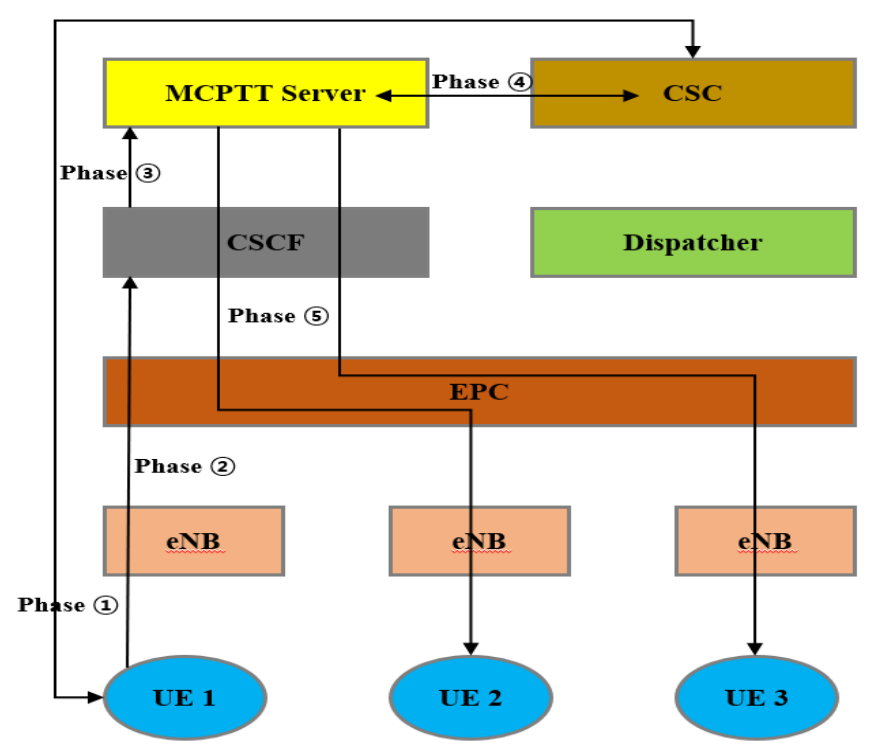
Figure 5. Flow Diagram of Creating an MCPTT Channel. The approximate delay of KPI 1 is calculated as approximately 200 ms using the network section from UE to peer entity through eNB, including (60 + 10 ms) × 2 (two-way delay) + UE L7 delay time (60 ms). The test is conducted at a fixed point of the wireless environment medium electric field, which does not include additional delays such as terminal mobility and RAN sharing. KPI 1, 2, and 3 should be measured for each terminal using a measuring instrument, and the average value is derived after repeating the process more than 50 times to ensure statistical significance of the result. The test environment is shown in Figure 6, and groups are set for each manufacturer